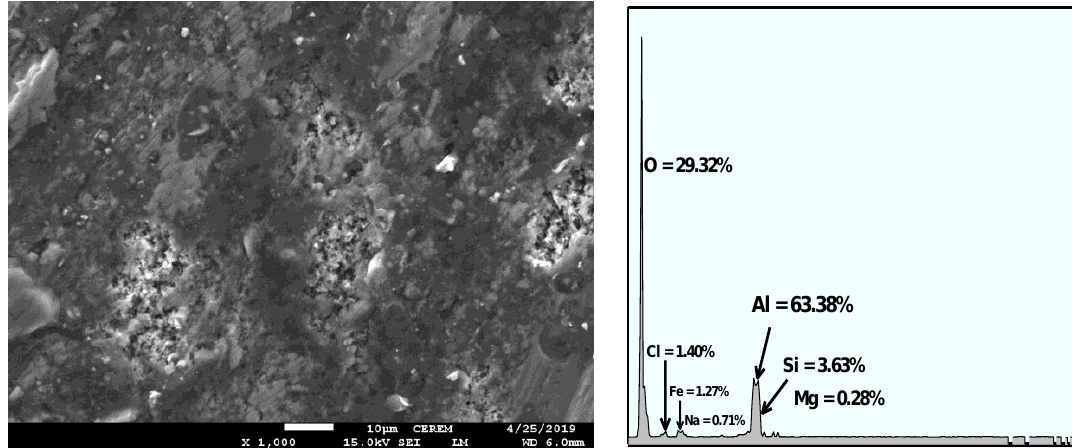
Figure 9. SEM and EDX for the recycled alloy that was extruded at 350 °C after 24 h exposure to NaCl solution at −680 mV that was applied for 40 min.